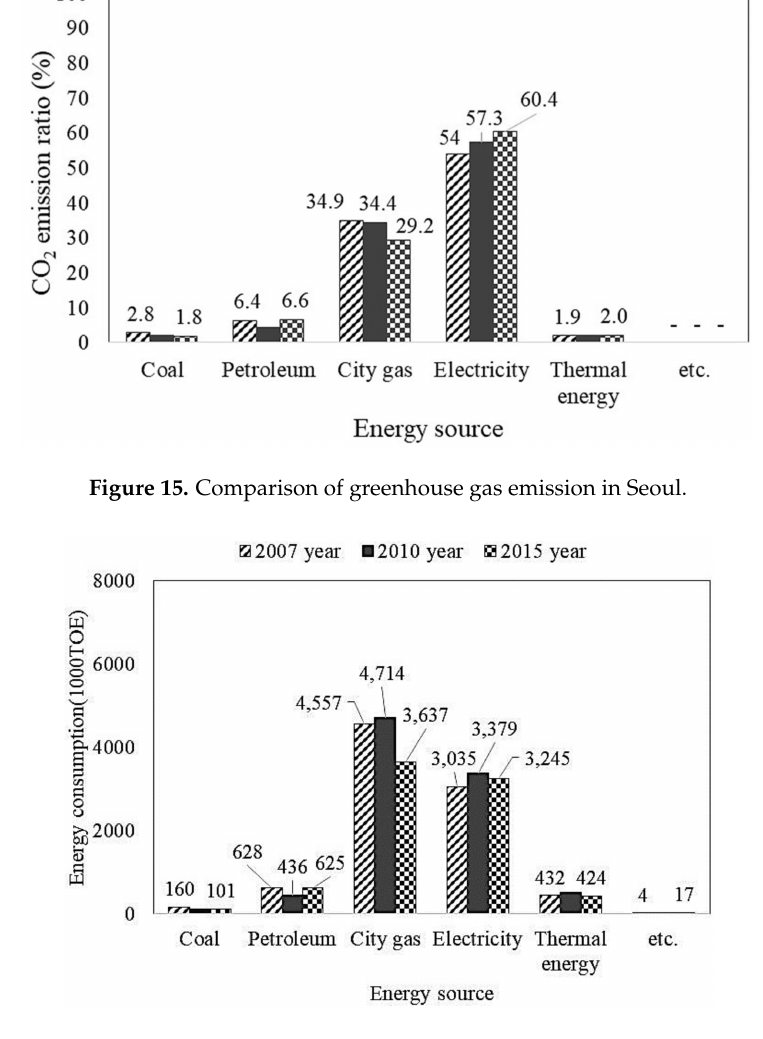
Figure 16. Energy consumption by buildings in